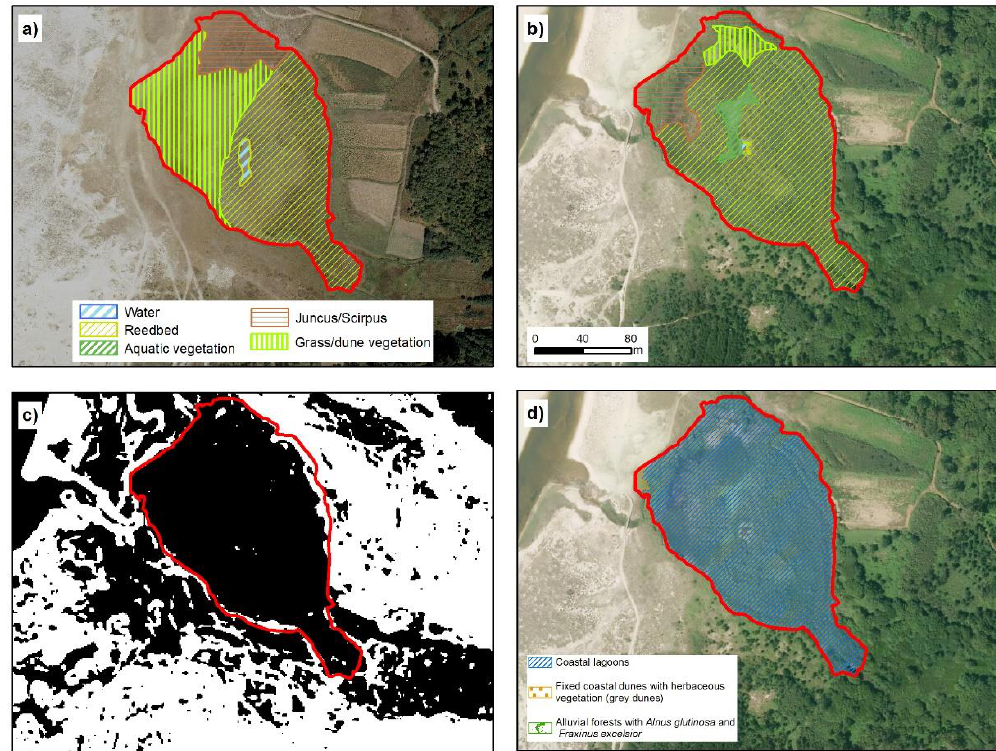
Figure 7. Lake of Xuño. ( a , b ) represent the temporal evolution of environmental units in 1989 and 2017, respectively. ( c ) shows TRI classification, in black, values below mean and in white the values above mean. ( d ) Official cartography representing the distribution of habitats from Annex I of Habitats Directive. The red line in all cases represent the extent marked for the lagoon by our analysis (IGN, [20]; Xunta de Galicia © ).